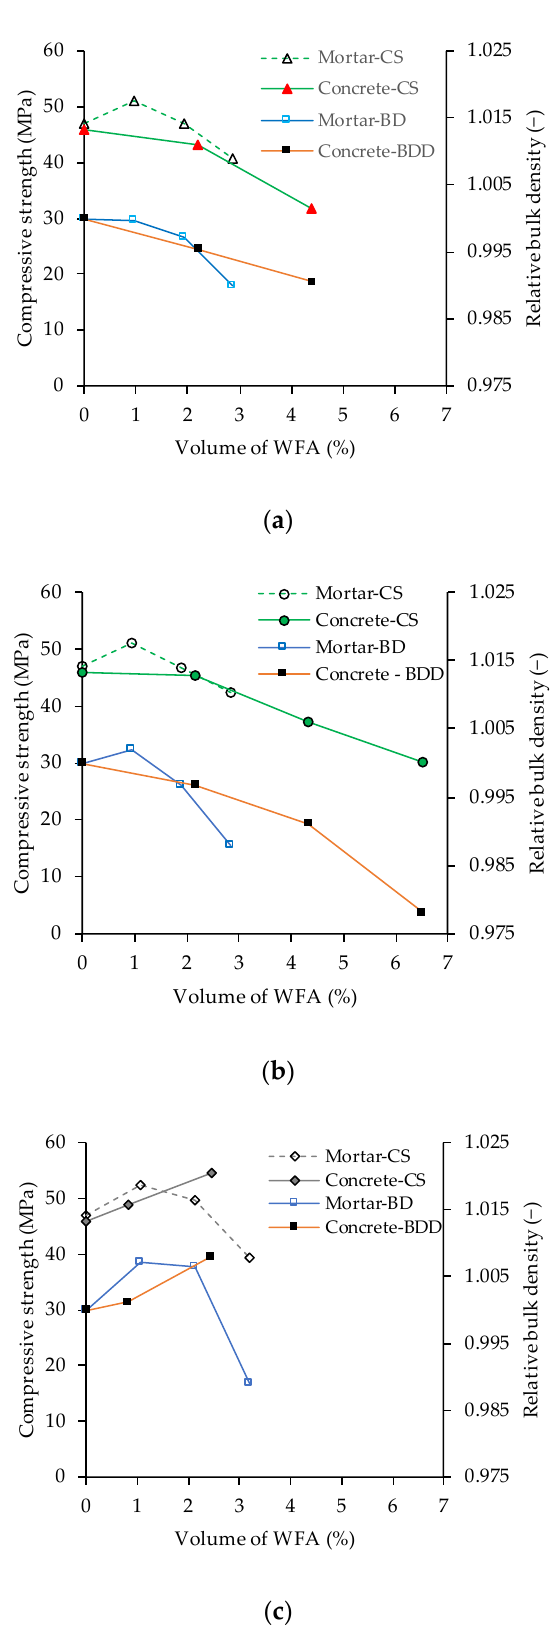
Figure 7. Compressive strength and relative bulk density of concrete and mortar mixtures with different volumes of WFA: ( a ) ash F4, ( b ) ash F5; ( c ) ash F6 (CS—compressive strength, BD—bulk density, BDD— bulk dry density) .